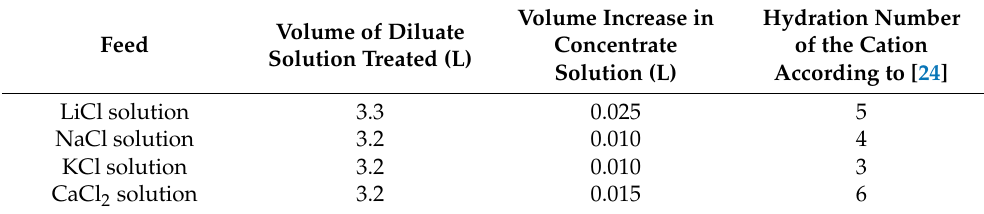
Table 3. Comparison of water transport through the membranes depending on the cation; investi- gations conducted at 20 V for concentrations for Cl - ions of 0.024 mol/L at ϑ = 21 ◦ C (cation molar concentration adjusted